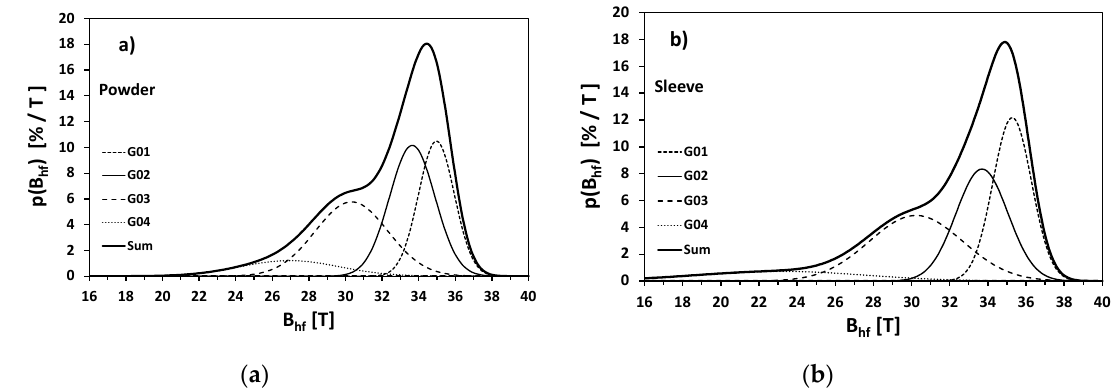
Figure 15. Room temperature transmission Mössbauer spectra for the initial powder and ready sleeve: ( a ) initial powder; ( b ) SLM fabricated sleeve. The components G01–G04 represent martensite while G05 does retained austenite.